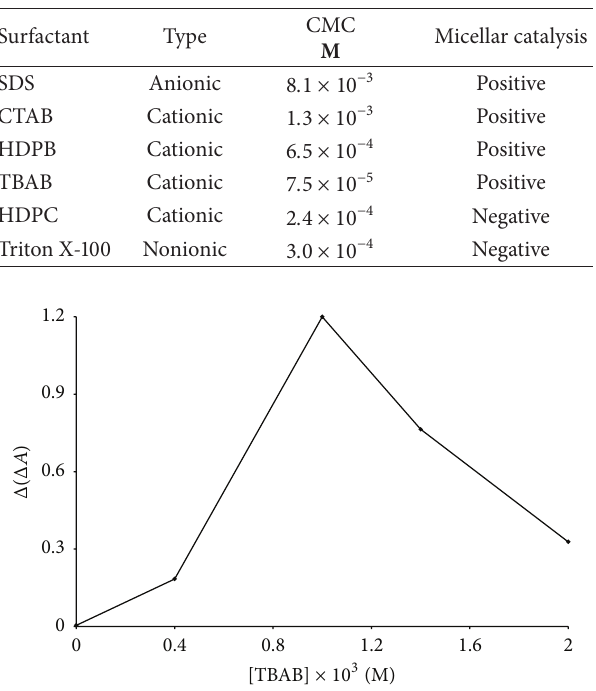
Table 1: Surfactants tested as potential micellar catalysts for the enhanced rate of SCG-amaranth-IO 4− reaction.